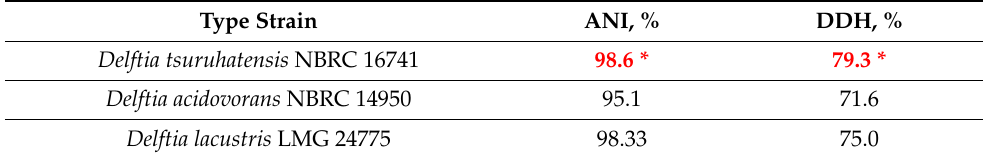
Table 1. ANI and DDH values of Delftia tsuruhatensis ULwDis3 with related type strains. Type Strain ANI, % DDH, % Delftia tsuruhatensis NBRC 16741 98.6 * 79.3 * Delftia acidovorans NBRC 14950 95.1 71.6 Delftia lacustris LMG 24775 98.33